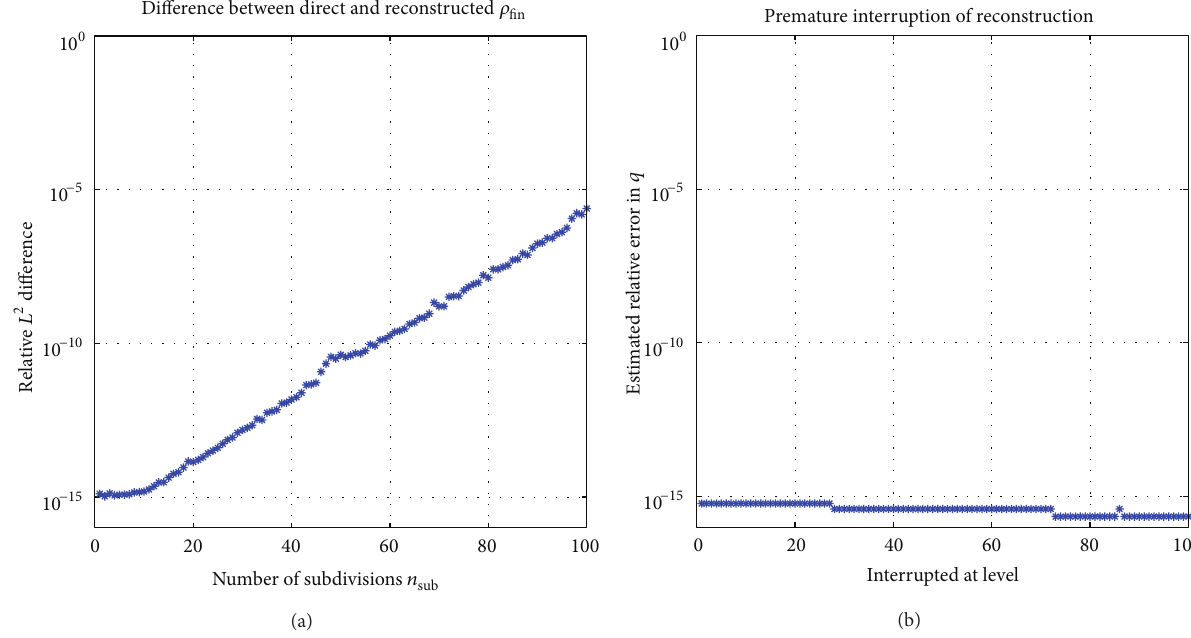
from the unstable equation (8) and 𝜌 reconstructed from ̃ 𝜌 of fin fin coa . part